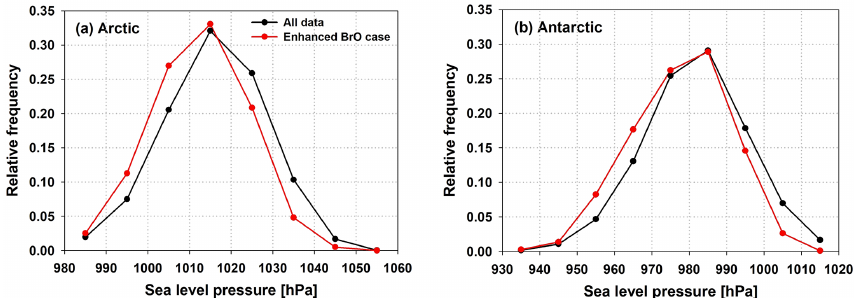
Figure 3. Frequency distribution of sea level pressure for all data (black line) and situations with enhanced BrO columns (red line) in (a) the Arctic and (b) Antarctic sea ice regions in spring (Arctic: March to April; Antarctic: September and